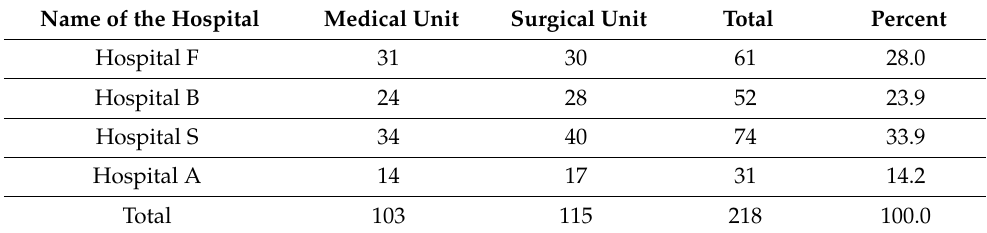
Table 1. Response workplace and units.